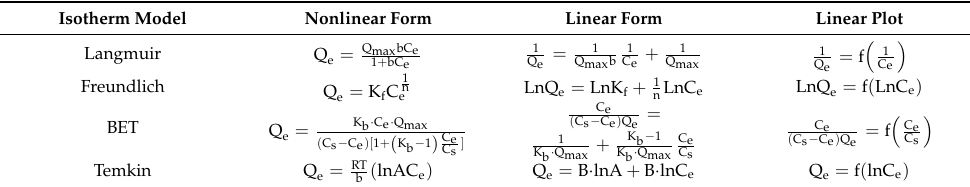
Table 5. Isotherm models of